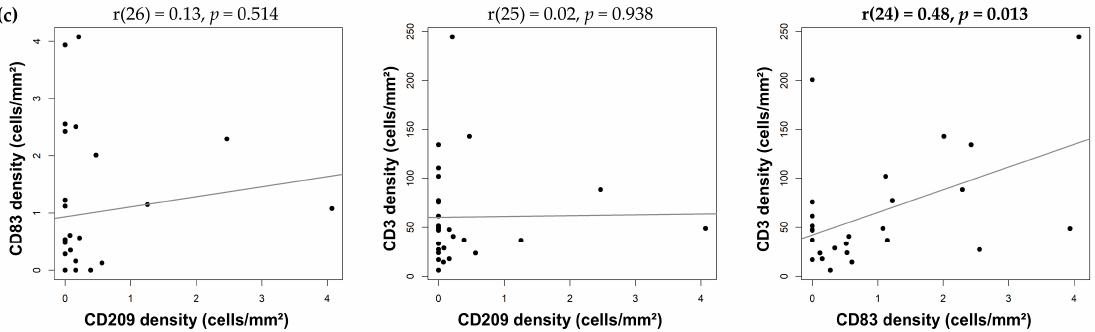
Figure 4. Linear regression and Pearson correlation for cell densities between the different cell types in IDC-P. Correlation between T cells and T cell subtypes ( a ), macrophages and T cells ( b ) and dendritic cells and T cells ( c ). Dots represent individual patients. Bold entities indicate statistically significant correlation.